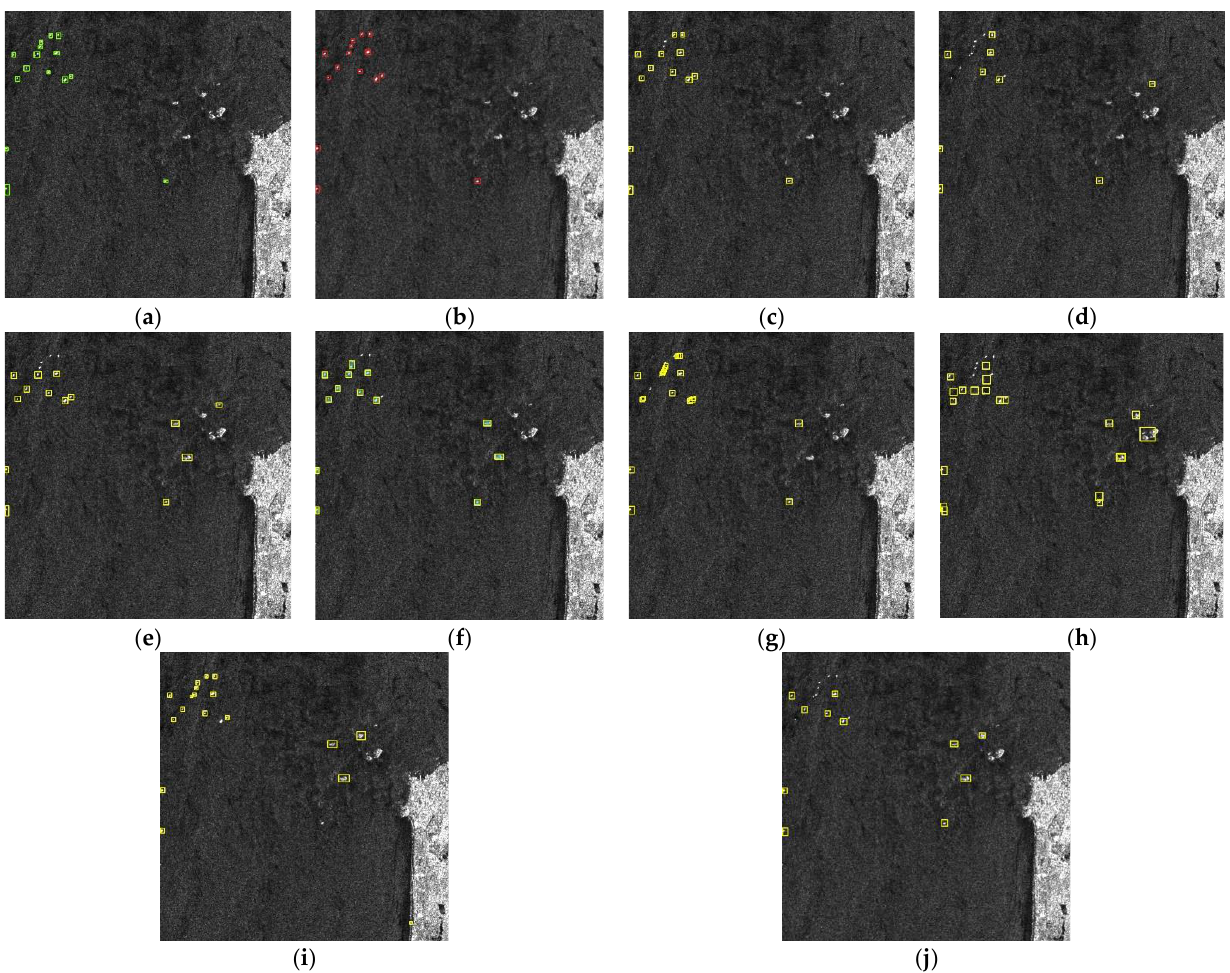
Figure 11. Partial detection results in LS-SSDD-v1.0, where the green boxes represent the ship positions marked in the dataset, the red boxes show the results detected by YOLO-SD and the yellow boxes represent the results inferred by other detection models. ( a ) ground truth; ( b ) YOLO-SD; ( c ) Dynamic R-CNN; ( d ) Faster R-CNN; ( e ) Grid R-CNN; ( f ) Mask R-CNN; ( g ) RetinaNet; ( h ) YOLOF; ( i ) YOLOv3; ( j ) Libra Faster R-CNN. Table 7 records the detection results obtained for YOLO-SD with other models. Only our algorithm succeeded in identifying not only the larger objects but also the smaller ships, without any false detection. In all the results, our model performs the best in terms of detection, even when compared to Mask R-CNN and Grid R-CNN (two models with high AP in Tables 4 and